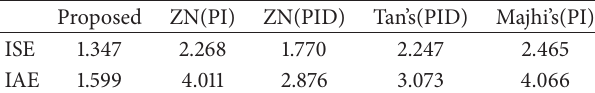
Figure 11: Comparisons with other methods for Example 1. Table 2: The ISE and IAE of five methods for Example